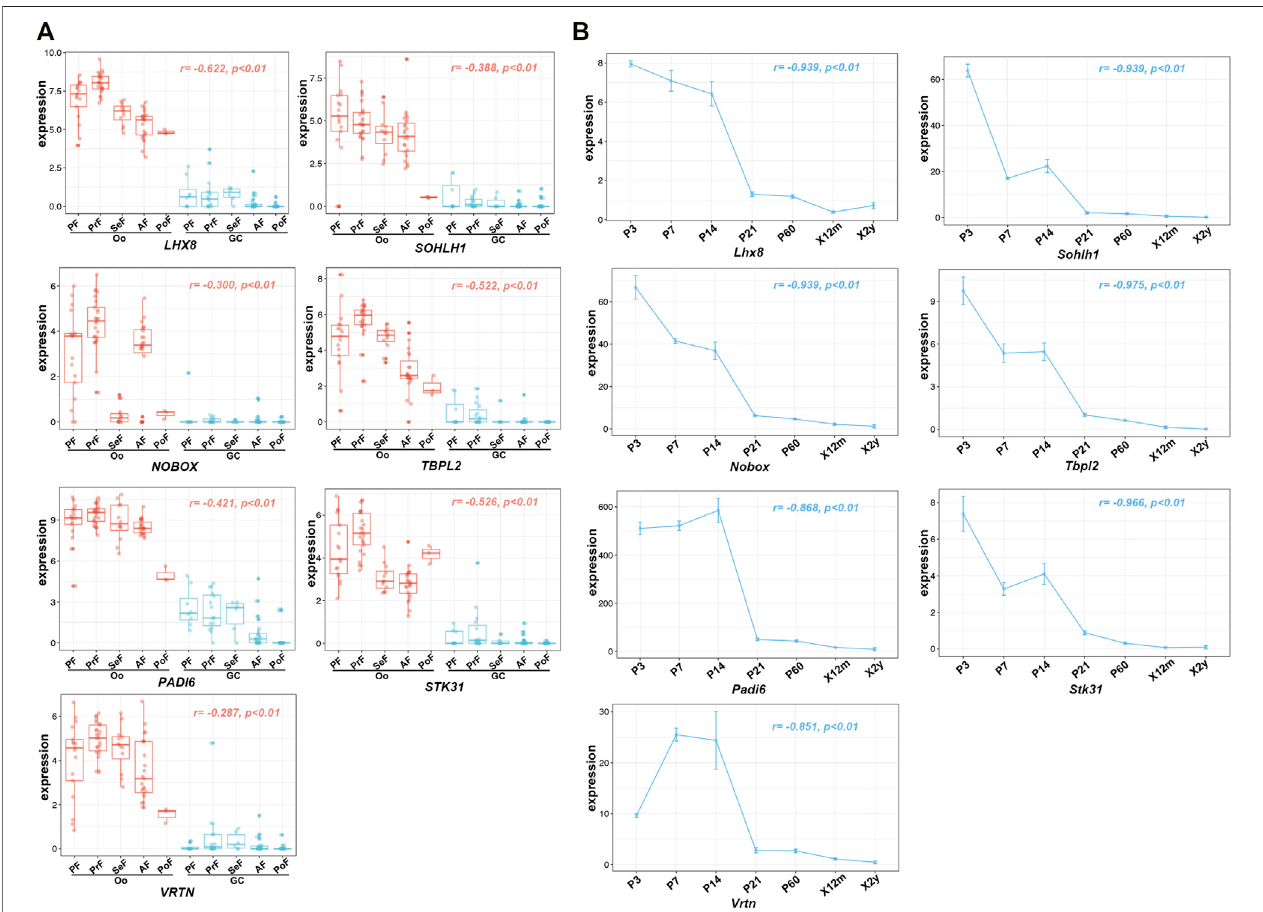
FIGURE 5 | Expression of seven identi fi ed potential genes in GSE107746 and GSE179888 datasets. (A) The expression levels of seven identi fi ed potential genes, Lhx8 , Sohlh1 , Nobox , Stk31 , Tbpl2 , Padi6 ,and Vrtn inthehumanOoorGCat fi vestagesoffolliculogenesisintheGSE107746dataset.Oo,oocyte;GC,granulosacells; PF,primordialfollicle;PrF,primaryfollicle;SeF,secondaryfollicle;AF,antralfollicle;PoF,preovulatoryfollicle;r,correlationcoef fi cient. (B) TheexpressiontrendswithBOA changesinmurineovariesfromtheGSE179888dataset.P,postnatalday;X12m,postnatal12 months;X2y,postnatal2 years;r,correlationcoef fi cient;p, p